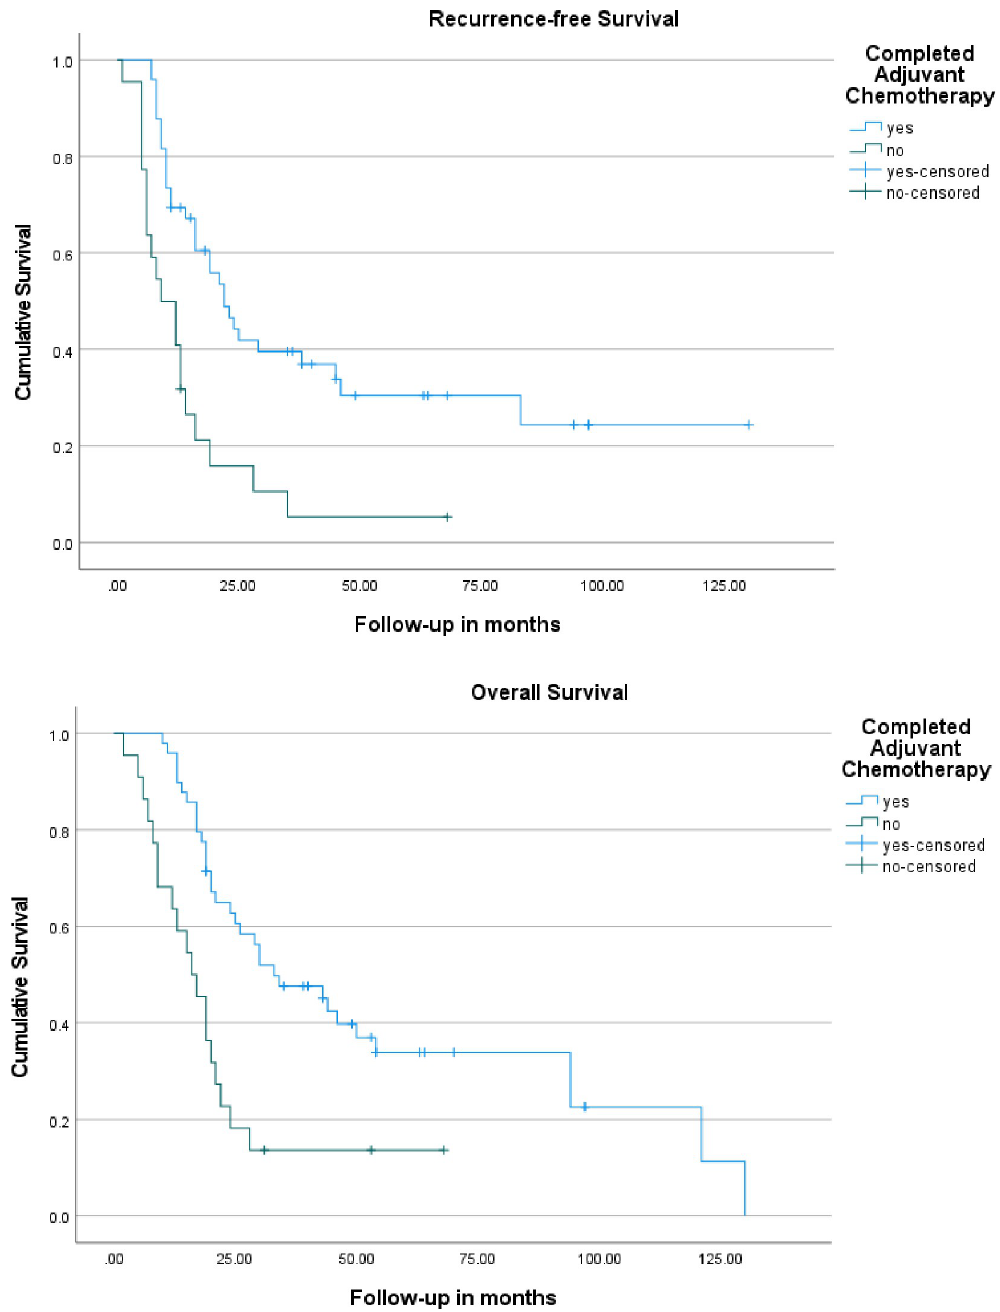
Fig 3. A. Kaplan-Meier recurrence-free survival curves of the patients who completed adjuvant chemotherapy to those who did not complete adjuvant therapy. B. Kaplan-Meier overall survival curves of patients who received planned adjuvant chemotherapy to those did not complete adjuvant